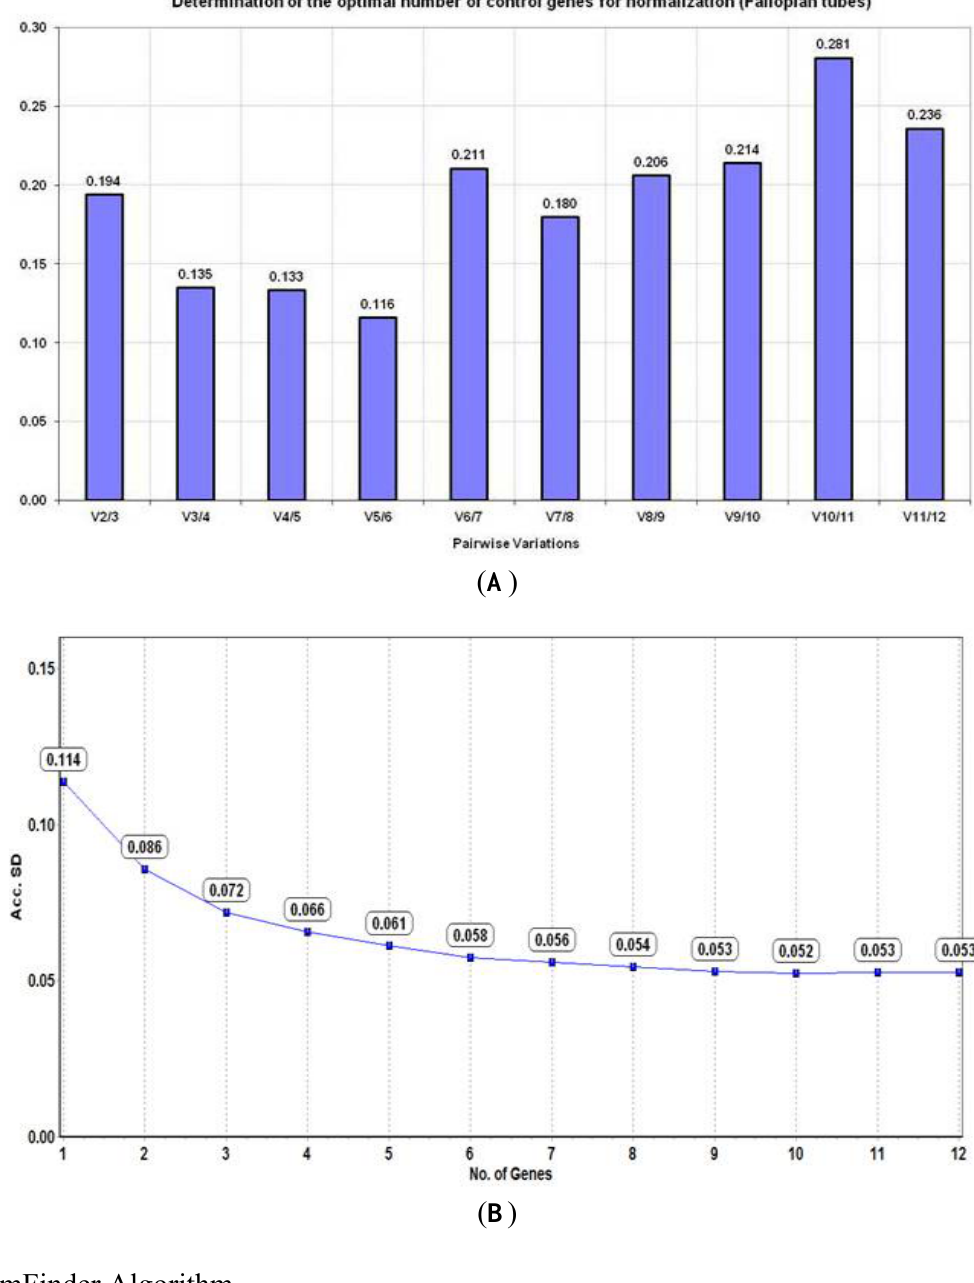
Figure 3. Determination of the optimal number of reference genes for normalization in fallopian tubes ( n = 12) based on their ( A ) pairwise variation (V) analysis using the geNorm algorithm and ( B ) accumulated standard deviation (Acc. SD) using the NormFinder